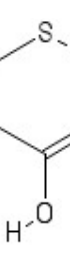
Figure 1. Structure of the N -acetylcysteine (NAC).